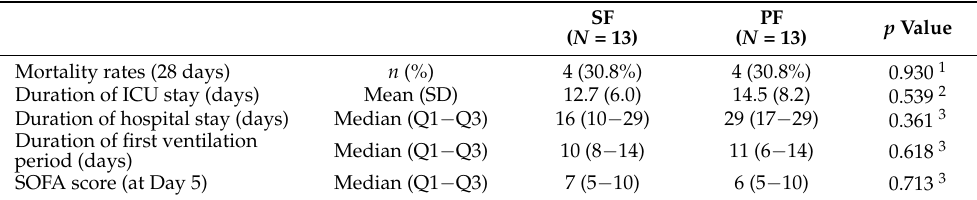
Table 5. Clinical outcome